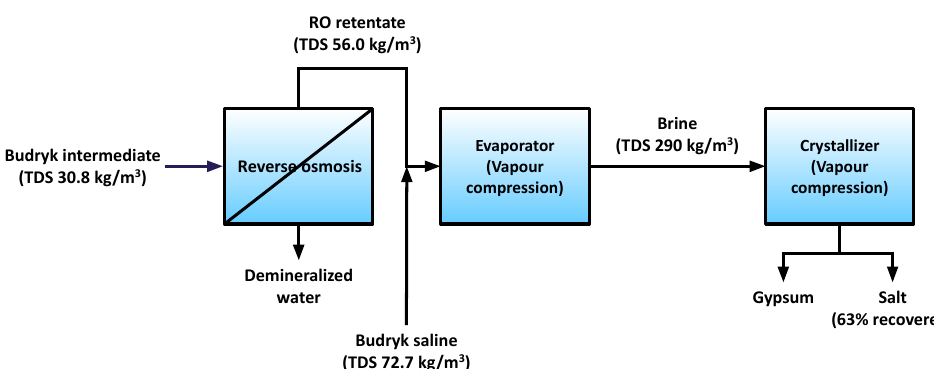
Figure 1. An overview of the ZOD technology for coal mine water treatment, made with data from [27].